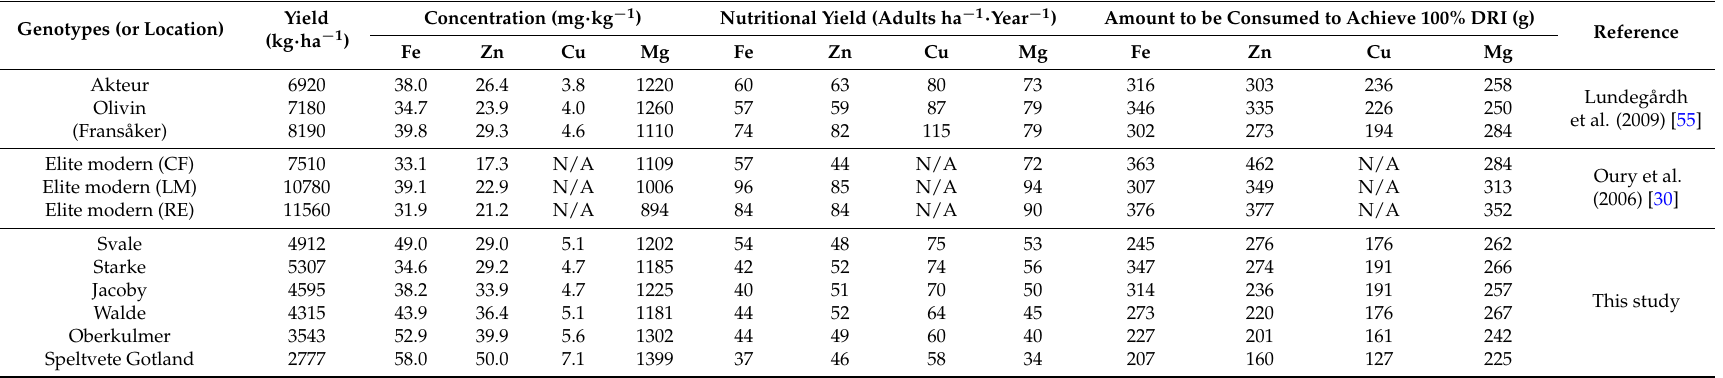
Table 8. Comparison of concentration (mg · kg − 1 ), nutritional yield (adults ha − 1 · year − 1 ), and the amount (g) that must be consumed in order to achieve 100% of the daily recommended intake [25] of Fe, Zn, Cu, and Mg, among selected genotypes evaluated in this study and wheat genotypes studied under conventional conditions in Sweden [54] or intensive conditions in France